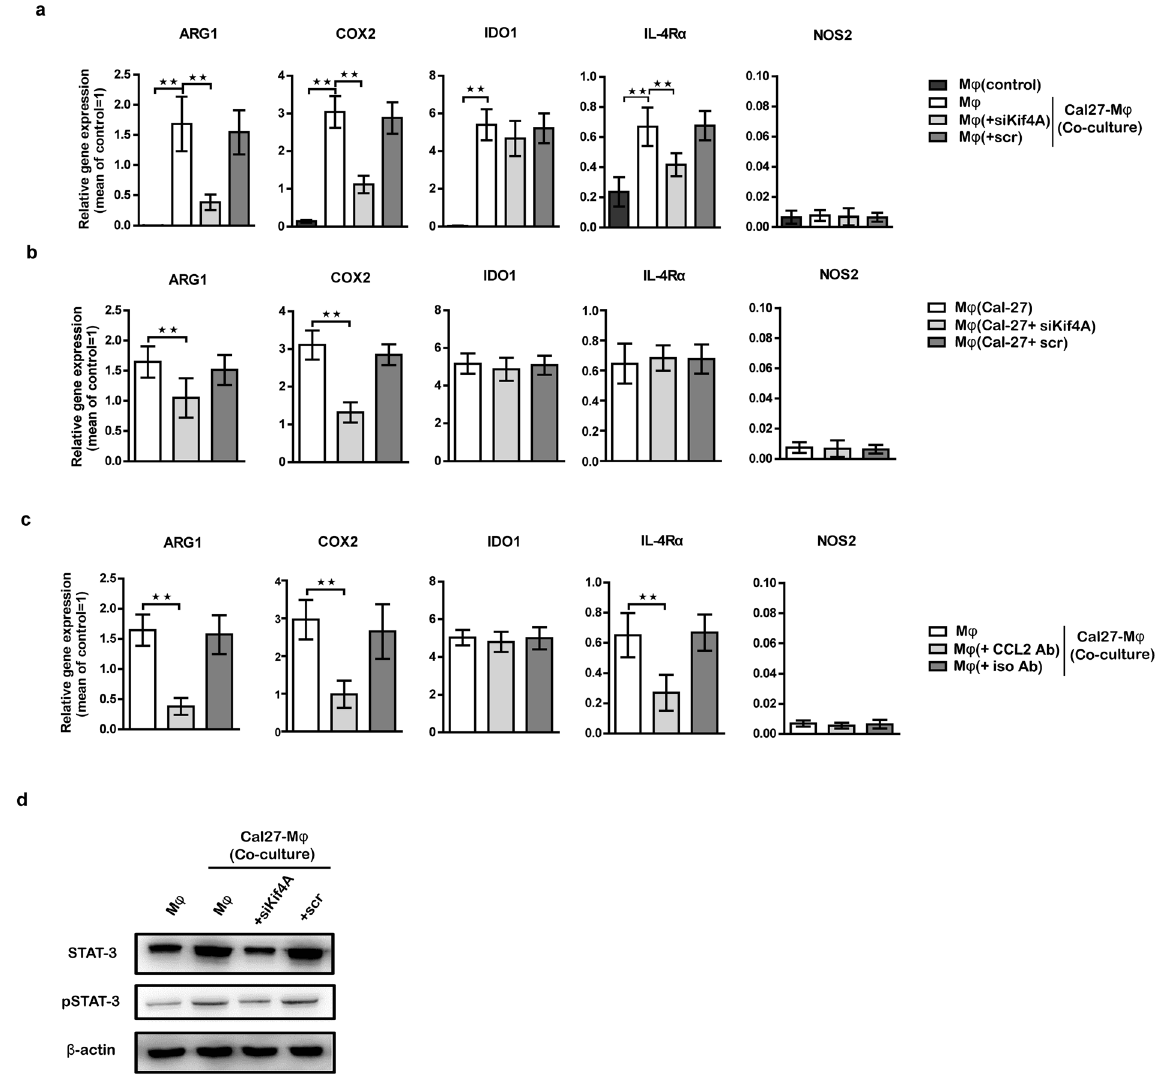
Figure 5. Kif4A-CCL2 promoted expression of suppressive molecules in macrophages. The transcription of typical suppressive molecules of THP-1-derived macrophages was measured by RTQ-PCR. ( a ) THP-1-derived macrophages were transfected by scr or siKif4A or not, and then co-cultured with Cal-27 for 24 h. THP-1- derived macrophages monocultures group was used as control. ( b ) Cal-27 were transfected by scr or siKif4A or not, and then co-cultured with THP-1-derived macrophages for 24 h. ( c ) CCL2 neutralizing antibody or isotype antibodies (10 μ g/mL) was added into supernatant of co-culture system for 24 h. Co-culture system without any antibody was used as control. ( d ) Western blotting analyzed the expression of ( p )STAT-3 in THP-1- derived macrophages from different groups as mentioned in ( a ). Relative gene expression was normalized to the expression of GAPDH mRNA and expressed as fold change for each relative gene reaction among the samples. All images represent five independent experiments, and all data are shown as the mean ± SEM. ** p <